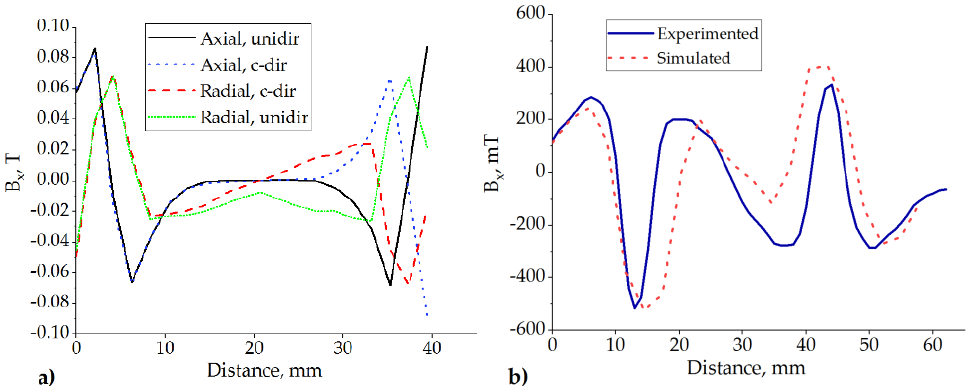
Figure 7. Magnetic flux density profiles along the surface of the slider: ( a ) All four magnet orientations simulated with a low resolution and reduced dimensions (see also Figure 5b – e). ( b ) Optimal setup of magnet orientations; simulation compared with the measurement.